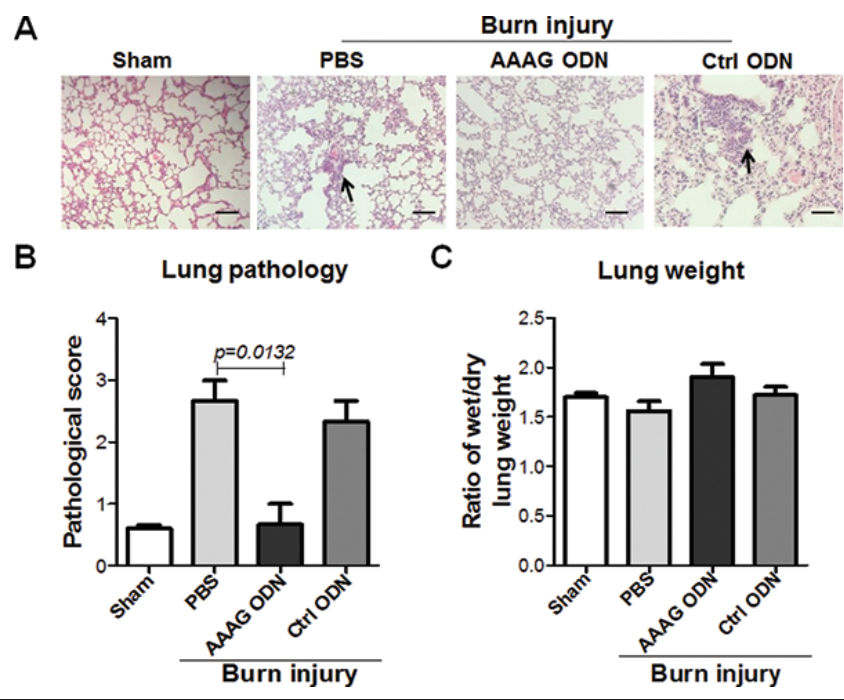
Figure 5. Alleviating role of AAAG ODN on ALI of burn-injured mice. The lungs of the mice at 24 h post burn were weighed and sectioned for H&E staining. The slices were (A) observed for pathological changes and (B) evaluated for pathological scores. (C) The wet/dry weight ratio of lung was used as a parameter to denote acute pulmonary edema. The black arrows indicate the infiltrated inflammatory cells. Data are repre- sented as mean ± SEM (n = 3 mice/group). *P < 0.05, **P < 0.01, ***P < 0.001. Scale bars = 50 μ m, magnification x